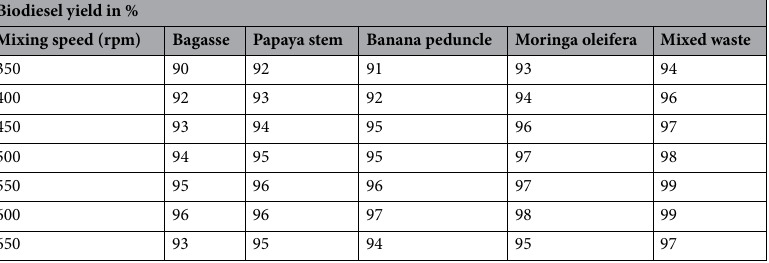
Table 5. Mixing speed (rpm) effects in biodiesel